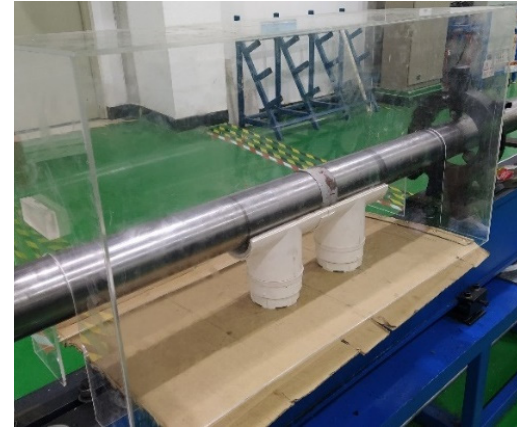
Figure 3. Physical photos of the test process. Table 2. Experimental program.